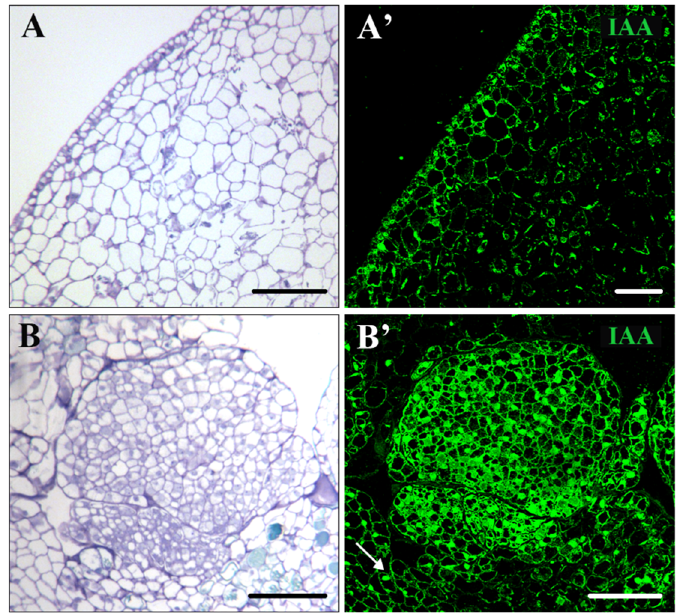
Figure 3. Immunolocalization of IAA before and after SE induction in immature zygotic embryos. ( A , B ) Micrographs of semithin sections stained by Toluidine blue of immature zygotic embryo ( A ) and proembryogenic masses (B). ( A’ , B’ ) Confocal microscopy images of IAA immunofluorescence (green signal) of immature zygotic embryo ( A’ ) and proembryogenic mass ( B’ ). Thin arrow points to vacuolated cells that surrounds the embryogenic cell cluster. Bars represent: ( A , A’ ) 50 µm and ( B , B’ ) 75 µm.